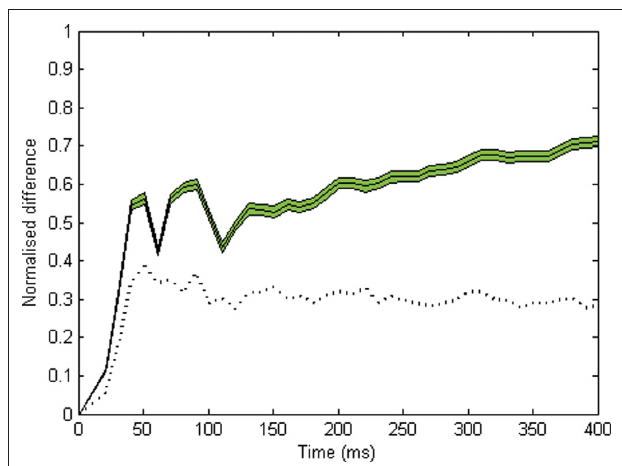
Figure 3 | Time course of normalized difference between the spiking activities for each object (10 ms time bins, see Materials and Methods). This difference should be zero if neurons coding for the two objects respond in synchrony, and should approach 1 if neurons for each object fire in alternation. The solid line indicates the average over 600 runs (green area: plus or minus s.e.m.). The dotted black line indicates the p = 0.05 level, obtained by randomly reassigning cells between objects, calculating the normalized PSTH difference, and taking the 30th highest value (among all 600) for each time bin. Significant segregation is observed within the first 50